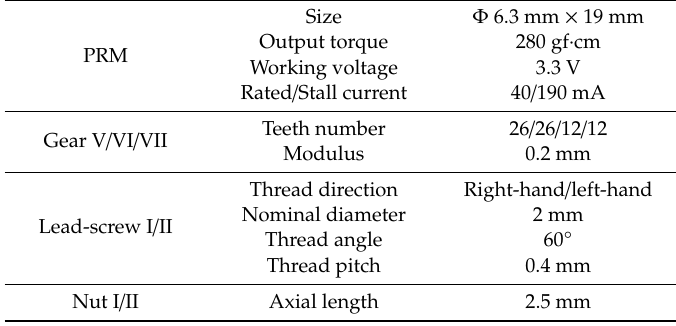
Table 4. Design parameters of the Linear Mechanism